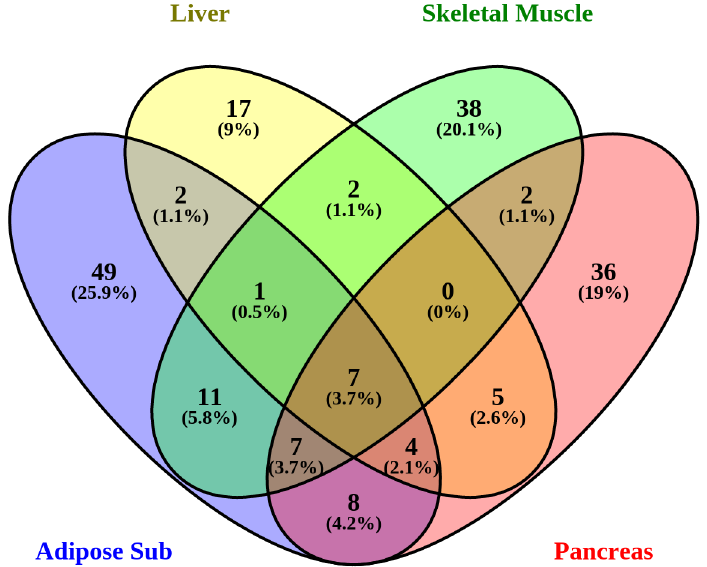
Fig 4. cis-eQTL in T2DM-relevant tissues. The Venn diagram indicates the numbers of cis-eQTLs in pancreas, liver, adipose subcutaneous and skeletal muscle, and the numbers shared among these tissues.